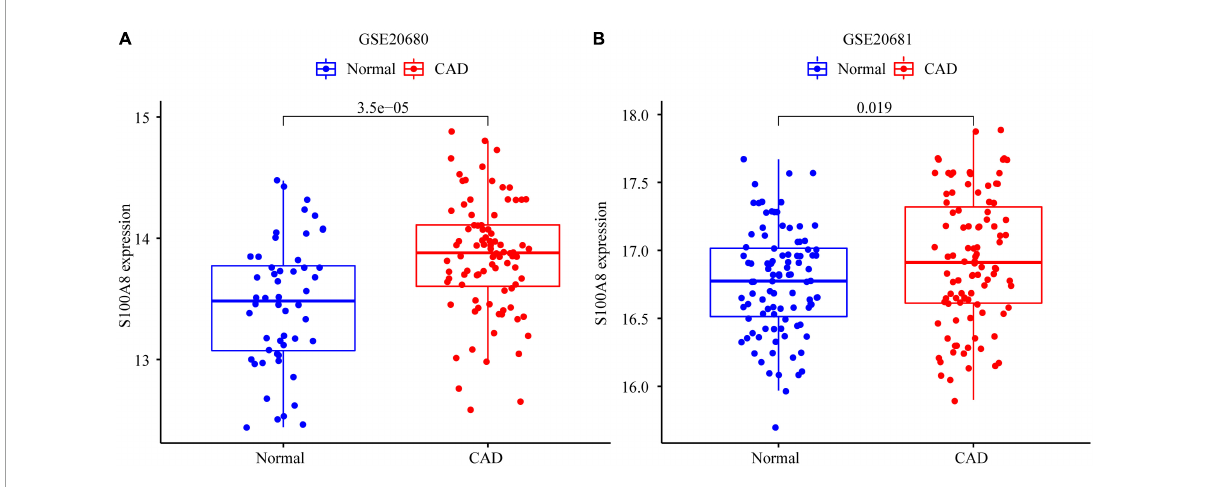
FIGURE7 Expression of S100A8 gene in the test set and validation set. (A) S100A8 expression in GSE20680. (B) S100A8 expression in